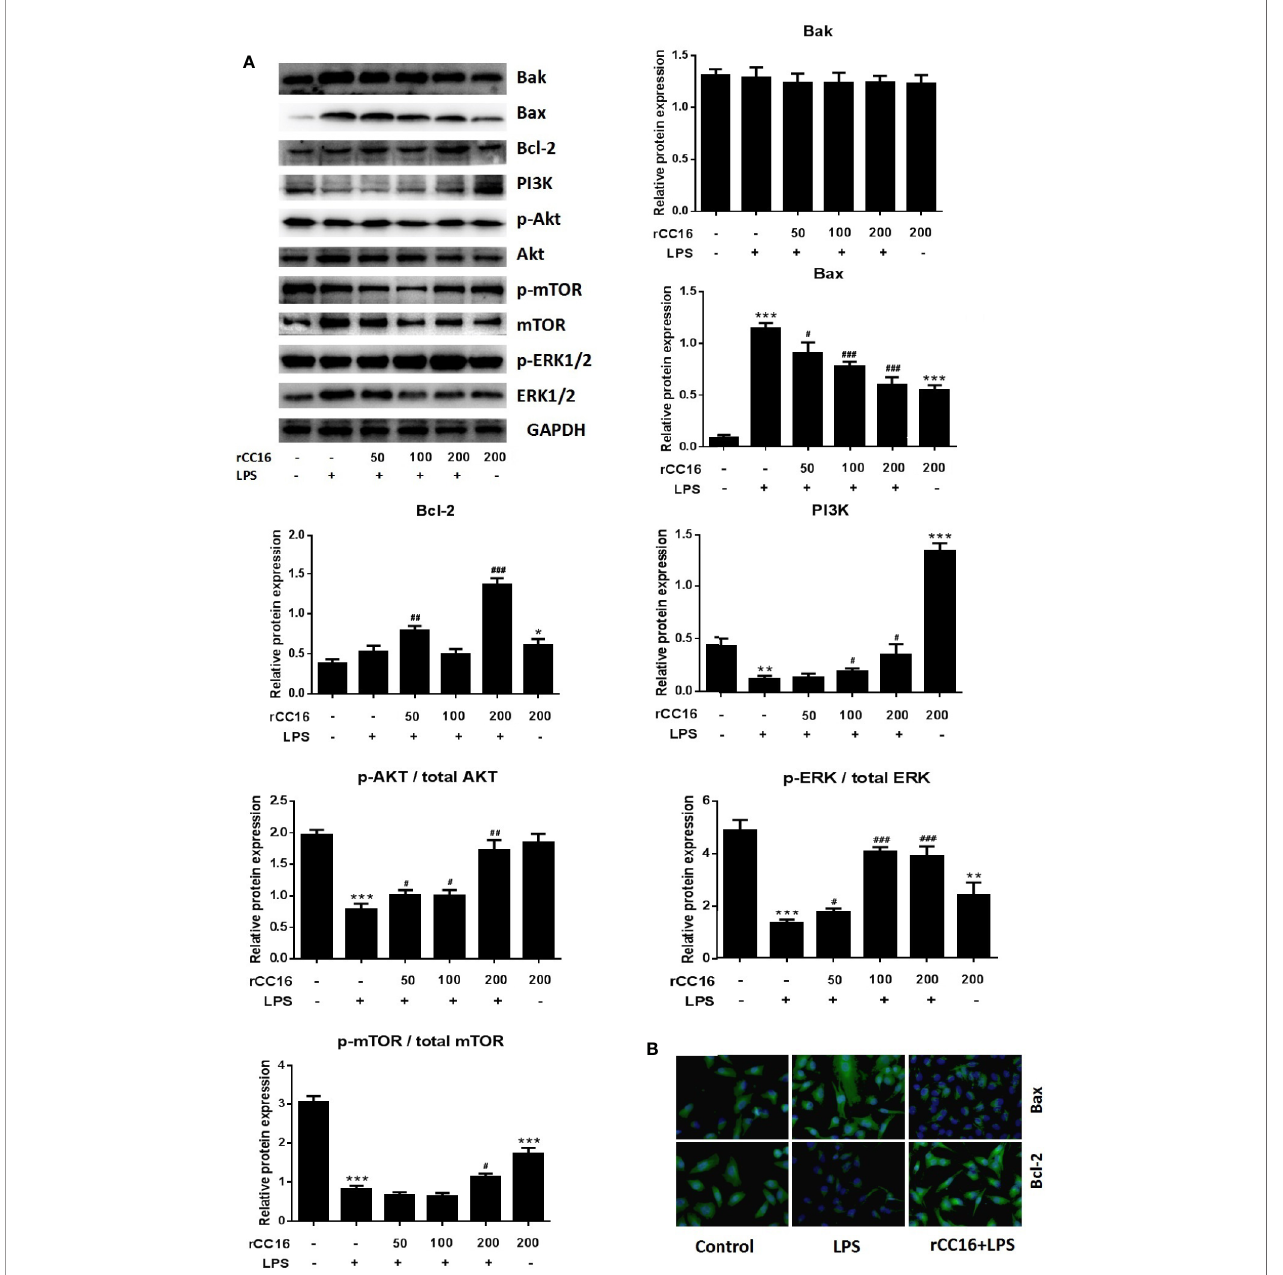
FIGURE 6 | rCC16 reversed LPS-induced A549 cell apoptosis through the PI3K/AKT/mTOR/ERK1/2 pathway. (A) Western blot analysis and quanti fi cation of apoptosis-related proteins and PI3K/AKT/mTOR/ERK1/2 signaling-related proteins in A549 cells stimulated with various concentrations of LPS for 24 h. (B) Immuno fl uorescence detection of Bax and Bcl-2 after pretreatment with or without 0.2 m g/ml rCC16 for 12 h and treatment with 200 m g/ml LPS for an additional 24 h. # p < 0.05, ## p < 0.01, and ### p < 0.001 compared with the untreated group; *p < 0.05, **p < 0.01, and ***p < 0.001 compared with the LPS group. Graphs show the mean ± SD of triplicate wells and represent three independent